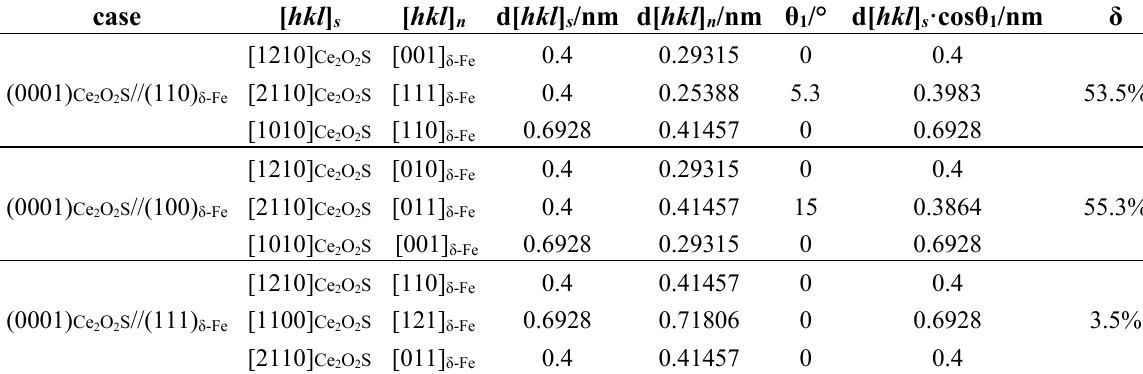
Figure 7. Relationship of crystallizing planes of Ce 2 O 2 S and δ-Fe. ( a ) between (0001) of Ce 2 O 2 S and the (110) of δ-Fe; ( b ) between (0001) of Ce 2 O 2 S and the (110) of δ-Fe; ( c ) between (0001) of Ce 2 O 2 S and the (111) of δ-Fe. Table 3. Results of calculation of two-dimensional lattice